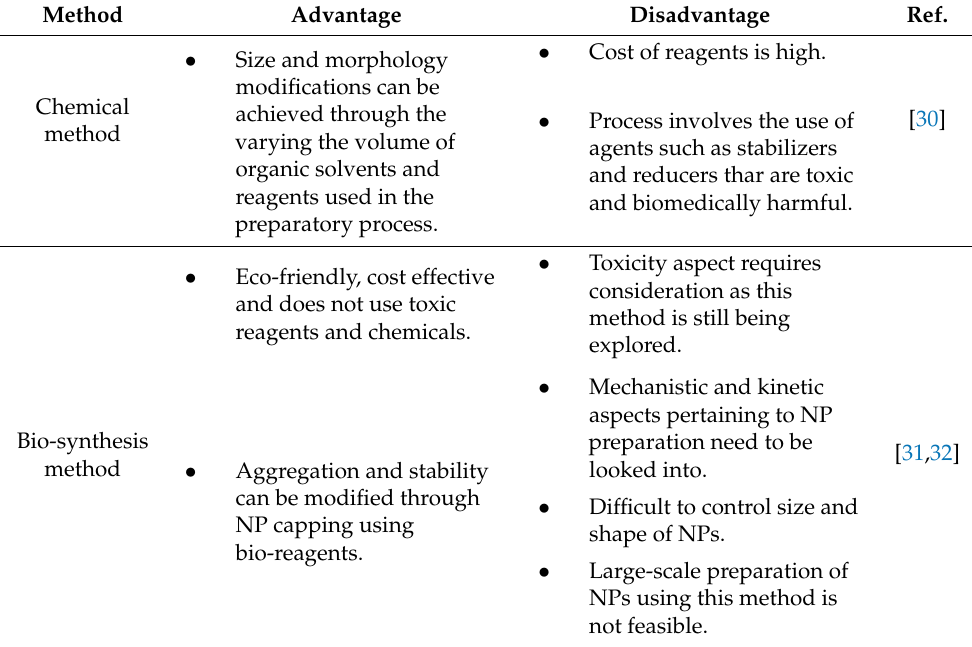
Table 1. Advantages and disadvantages of chemical and bio-synthetically prepared gold